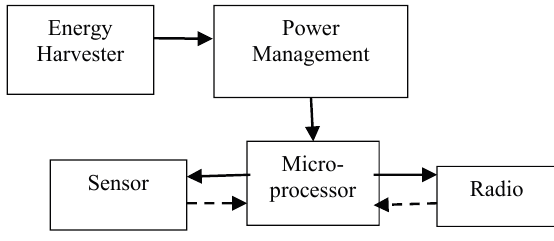
Figure 7. Block diagram of the self-powered wireless sensor node.